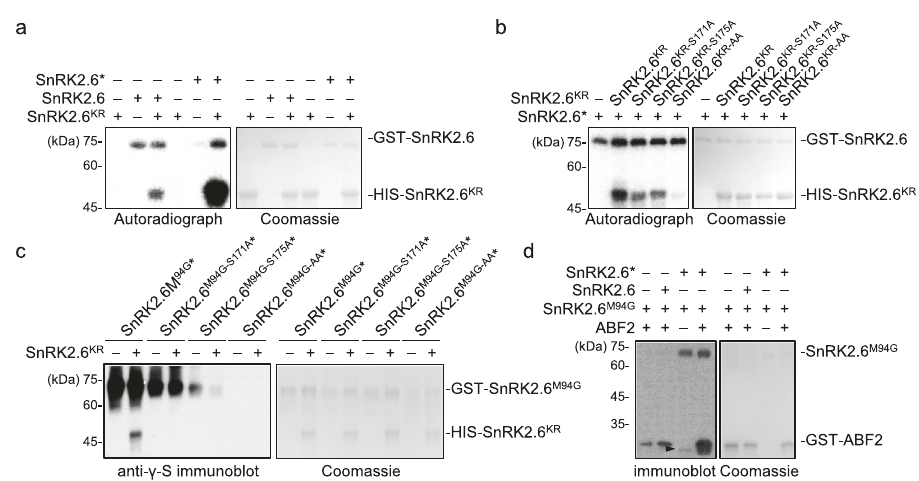
Fig. 2 Intermolecular transphosphorylation ampli fi es SnRK2 activation. a Recombinant SnRK2.6 and pre-activated SnRK2.6 (SnRK2.6*) phosphorylate HIS-SnRK2.6 KR . Aliquot of SnRK2.6 was pre-incubated with HIS-SUMO-RAF10-KD coated on Ni-NTA beads for 30 min. After removal of HIS-SUMO- RAF10-KD by centrifugation, pre-activated SnRK2.6 (SnRK2.6*) was used to phosphorylate HIS-SnRK2.6 KR , in the presence of [ γ - 32 p]ATP. Same amount of SnRK2.6 without pre-activation was used as control (lanes 1 – 3). Lane 4 indicates no remaining RAF10-KD after removal. Autoradiograph (left) and Coomassie staining (right) show phosphorylation and loading, respectively, of puri fi ed GST-SnRK2.6 and HIS-SnRK2.6 KR . b Pre-activated SnRK2.6 (SnRK2.6*) phosphorylates SnRK2.6 KR , SnRK2.6 KR-S171A , SnRK2.6 KR-S175A , or SnRK2.6 KR-AA , in the presence of [ γ - 32 p]ATP. Autoradiograph (left) and Coomassie staining (right) show phosphorylation and loading, respectively, of puri fi ed GST-SnRK2.6 and HIS-SnRK2.6 KR proteins. c Transphosphorylation activity of pre-activated SnRK2.6 M94G , SnRK2.6 M94G-S171A , SnRK2.6 M94G-S175A , and SnRK2.6 M94G-AA on SnRK2.6 KR . d Effect of recombinant SnRK2.6 and pre-activated SnRK2.6 (SnRK2.6*) on SnRK2.6 M94G activity. For c to d , Anti- γ -S immunoblot (left) and Coomassie staining (right) show thiophosphorylation and loading, respectively, of recombinant GST-SnRK2.6 M94G , HIS -SnRK2.6 KR , and GST-ABF2. Arrow indicates partial degraded band of GST-SnRK2.6 M94G . Images shown are representative of at least two independent experiments. Source data are provided in Source